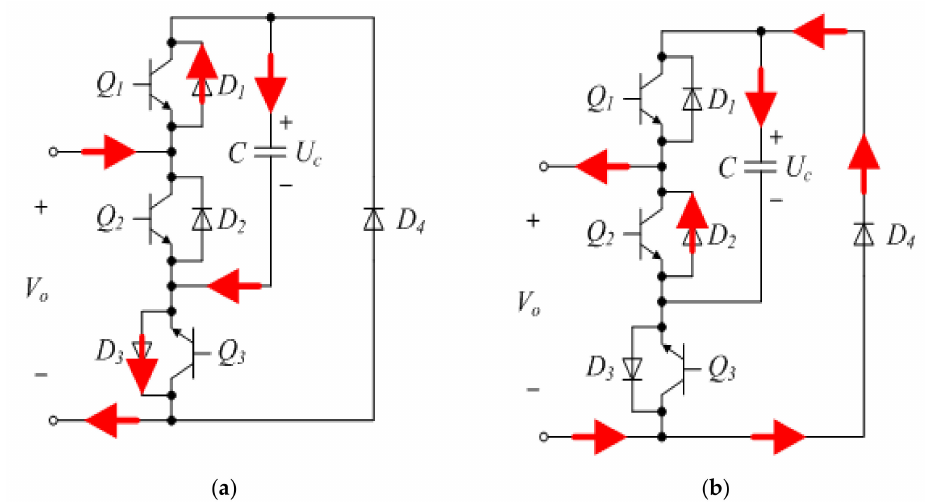
Figure 4. Current path of CSSM in the case that DC short current is flowing in abnormal operation mode: ( a ) current is flowing into the submodule; ( b ) current is flowing out of the submodule.